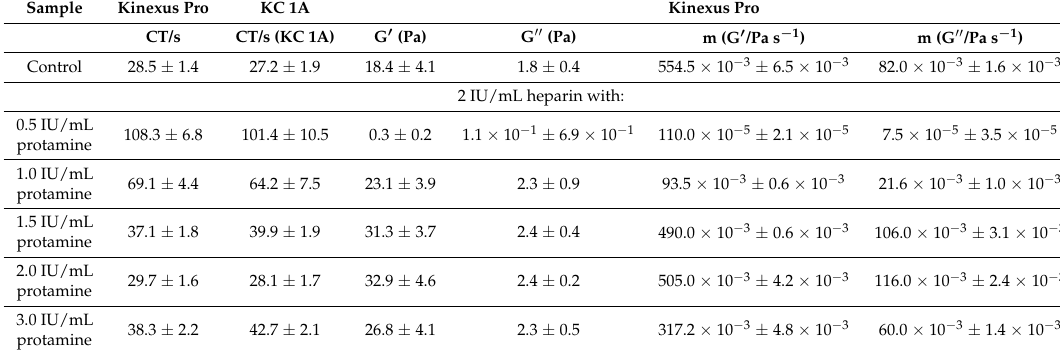
Table 4. Summary of the clotting time (CT), elastic (G (cid:48) ) and viscous (G (cid:48)(cid:48) ) shear moduli at 300 s and linear slopes (m (G (cid:48) ) and m (G (cid:48)(cid:48) )). Citrated blood was heparinised (2.0 IU/mL) and antagonised with various concentrations of protamine (0.5–3.0 IU/mL) before activation with Thromborel ( n = 3). Citrated blood without heparin activated by Thromborel served as